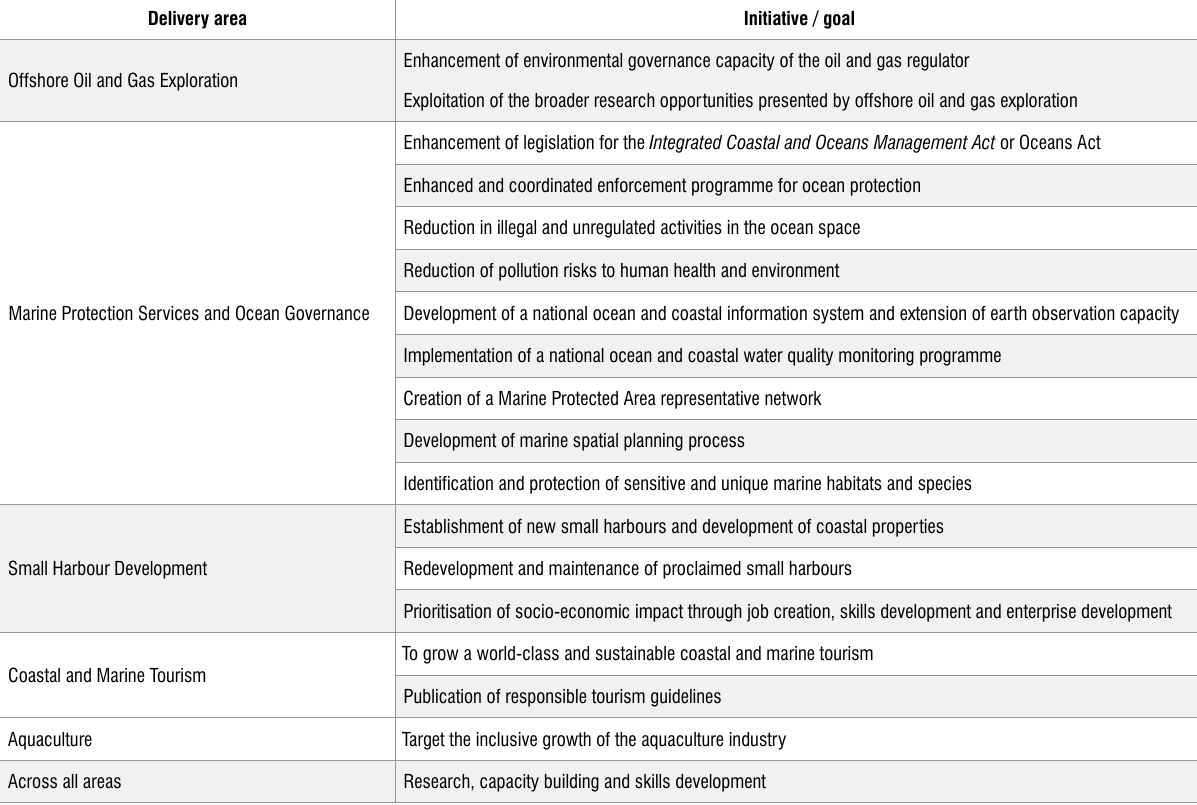
Key initiatives or goals of each delivery area of Operation Phakisa: Unlocking the Economic Potential of South Africa’s Oceans that underpin blue economy